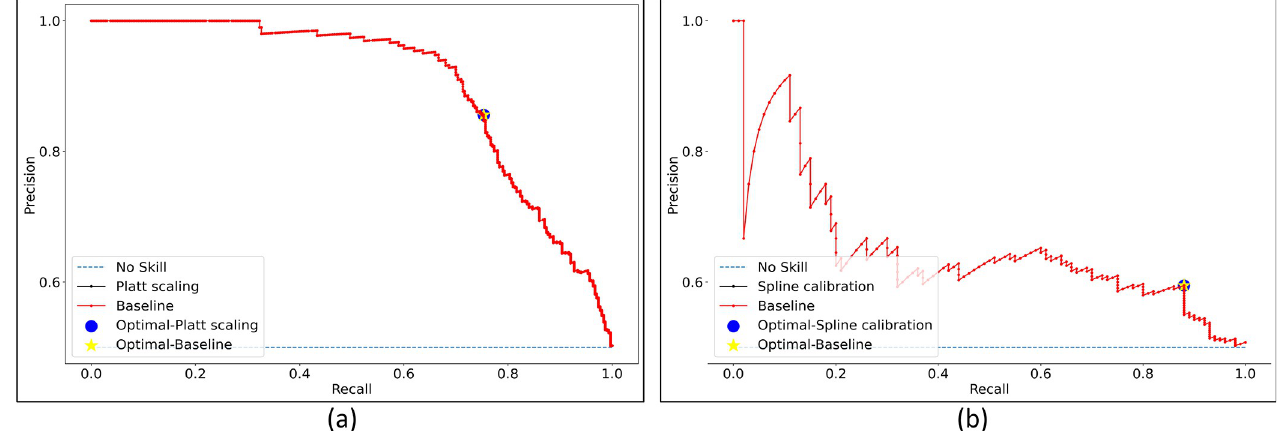
Fig 9. PR curves with their optimal thresholds obtained using the uncalibrated and calibrated probabilities for the Set-20 dataset, individually constructed from the (a) APTOS’19 fundus and (b) Shenzhen TB CXR datasets.